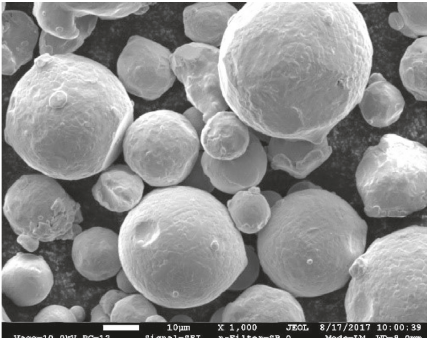
Figure 1: Morphology of powder used for SLS